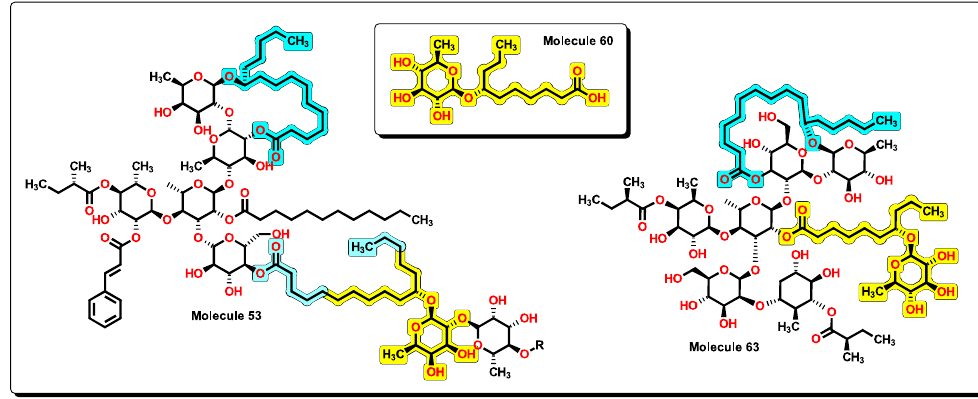
Figure 17. Partial chemical structure of 53 and complete molecule 63 . A chemical core of 60 is displayed